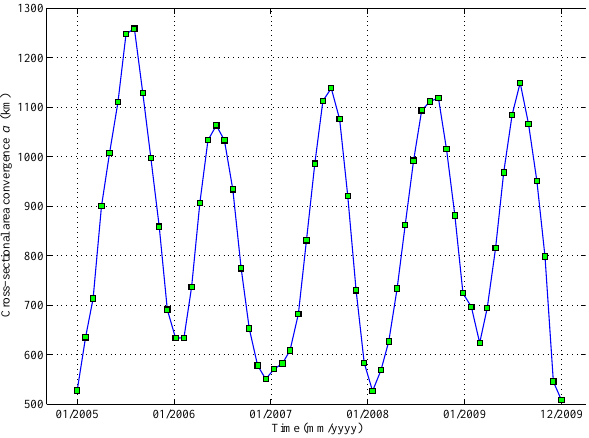
Figure 12. Seasonal variation of the cross-sectional area conver- gence a due to the changes in residual water level slope d h/ d x at x = 456km in the Yangtze